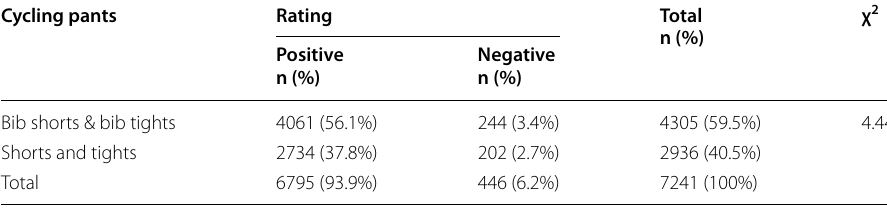
Table 4 Differences of the rating of reviews on cycling